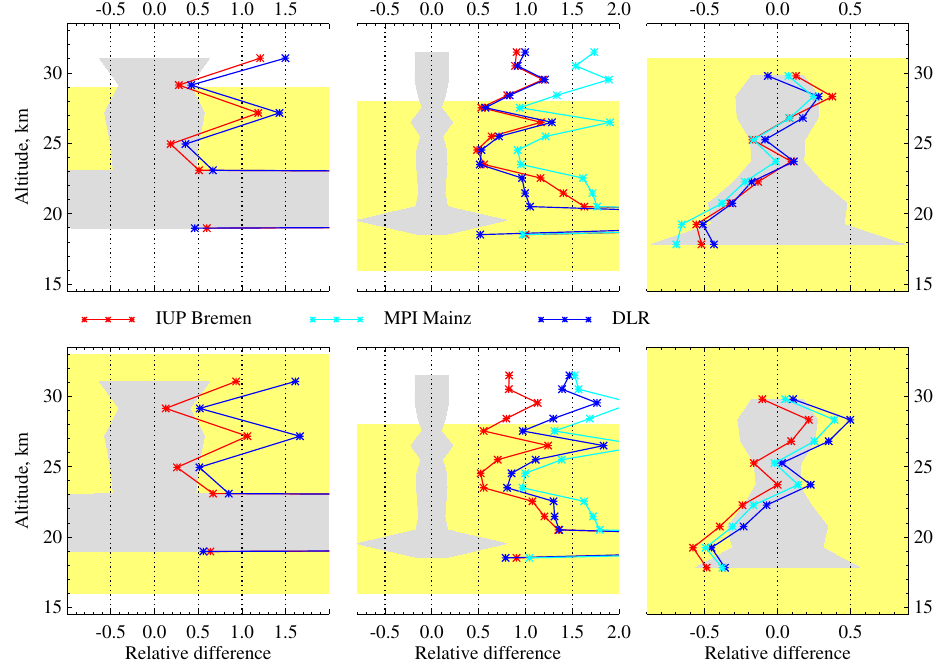
Fig. 30. Same as in Fig. 29 but for relative differences with respect to balloon-borne TRIPLE results, e.g., IUP Bremen/TRIPLE-1, etc.